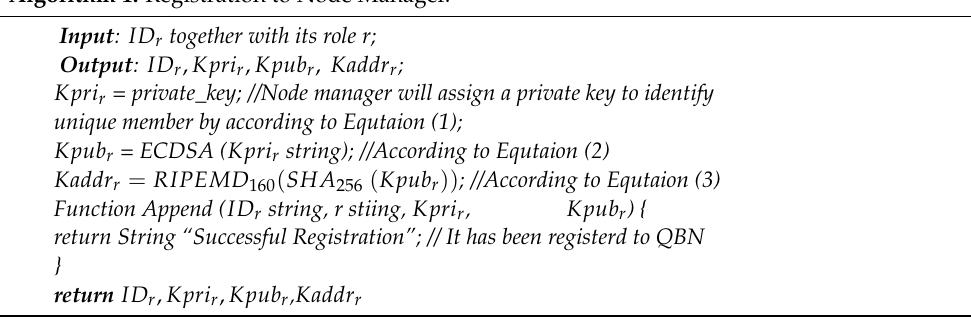
Figure 4. The interaction relationship among DApp, IPFS, and QBN in the proposed framework. Algorithm 1: Registration to Node